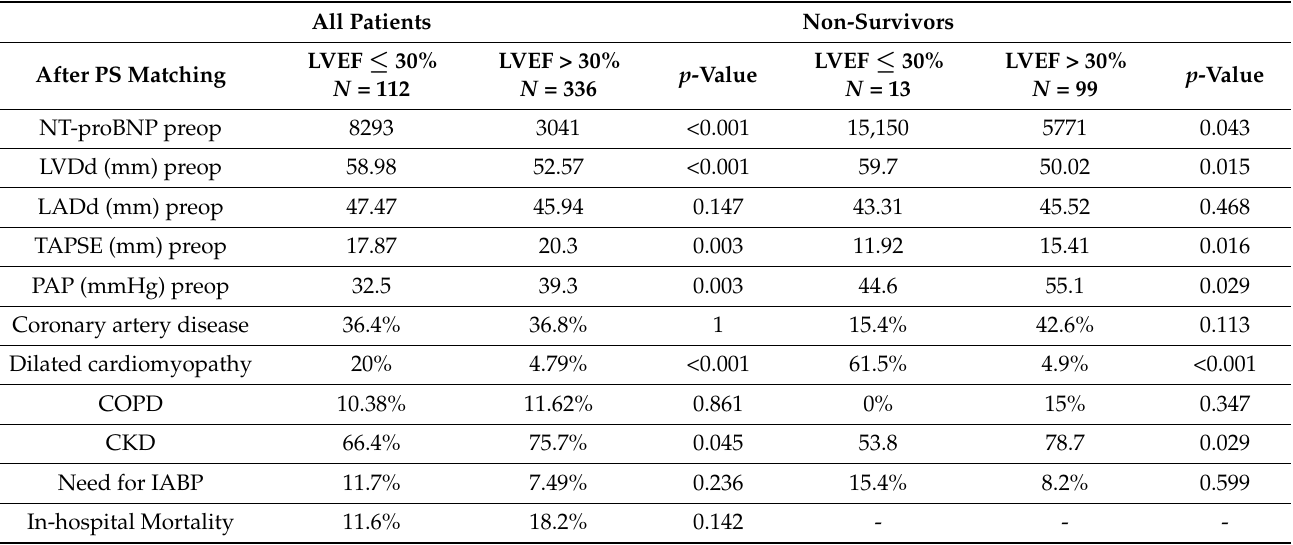
Table 5. Risk profile and relation to mortality in patients with LVEF ≤ 30% and >30% after propensity score